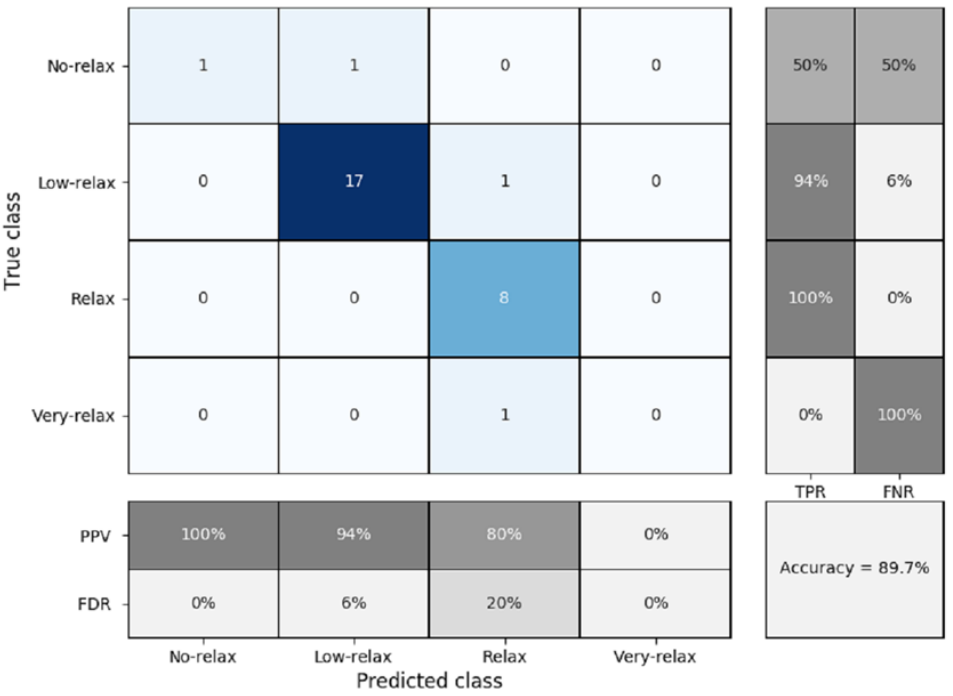
Figure 12. Confusion matrix for k-nearest neighbors (K-NN) classification and five-fold cross validation (all participants), where PPV = positive predicted value, FDR = false discovery rate, TPR = true positive rate or sensitivity, and FNR = false negative rate or specificity.